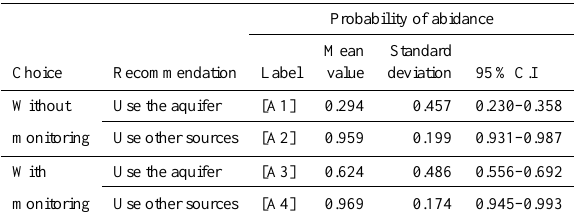
Table 1. Probabilities that participants will abide by DM recom-